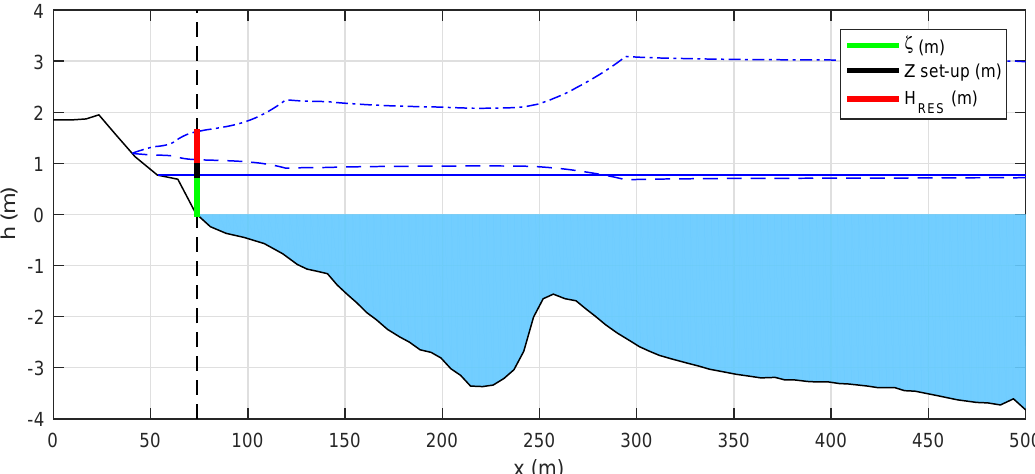
Figure 2. Example of the wave transformation model results and definition of the boundary conditions at the isobath 0 m.